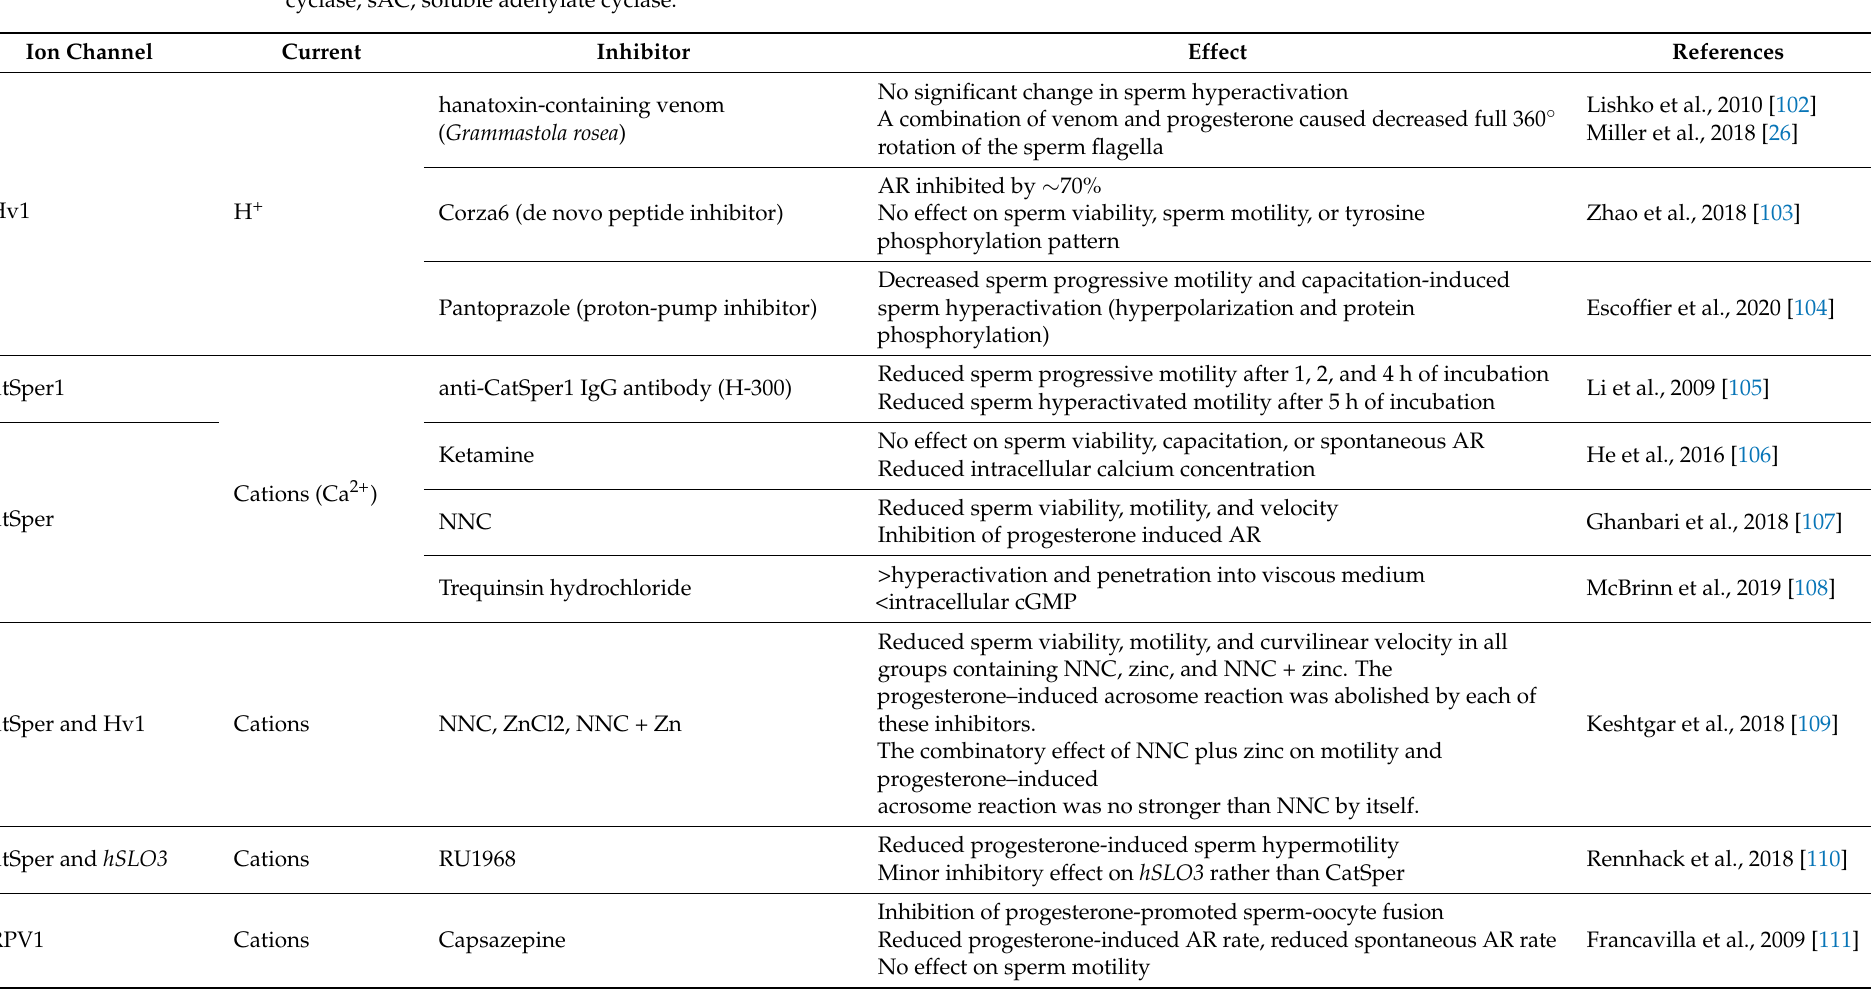
Table 2. Studies and characterization of ion channels by pharmacological inhibition or activation on human spermatozoa. AR, acrosomal reaction; AC, adenylate cyclase; sAC, soluble adenylate